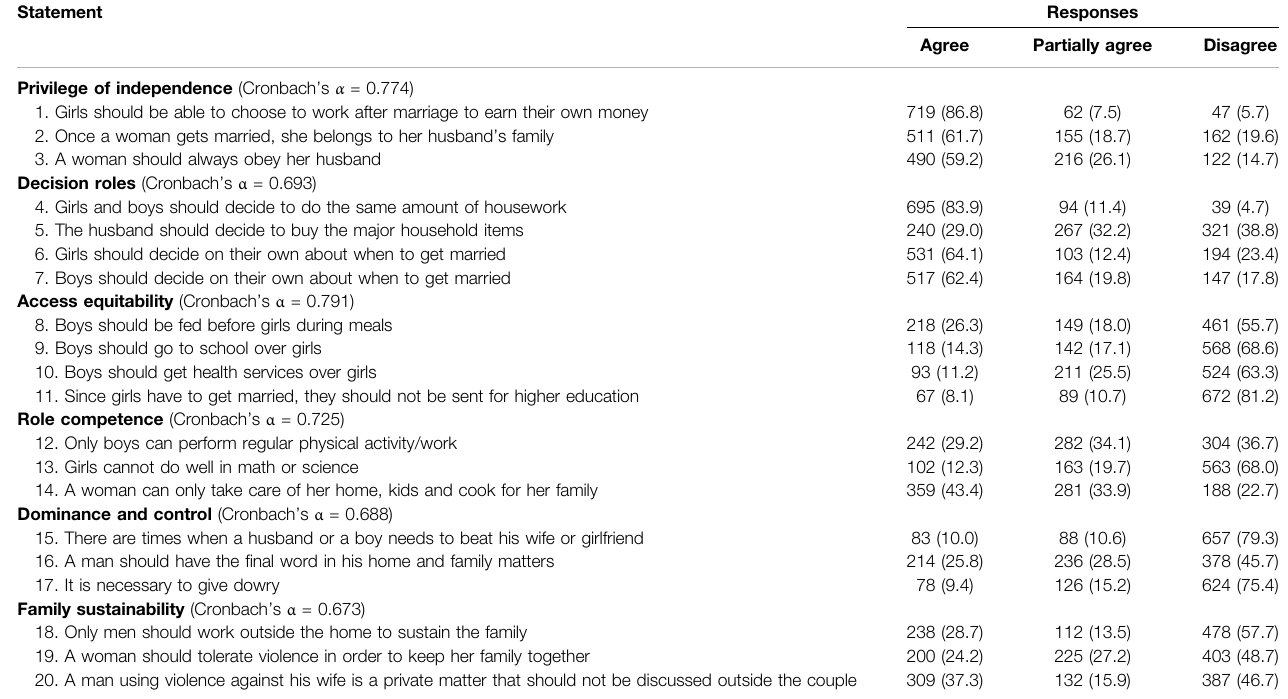
Values within the parentheses represent row percentages corresponding to the number of responses presented outside the parentheses.